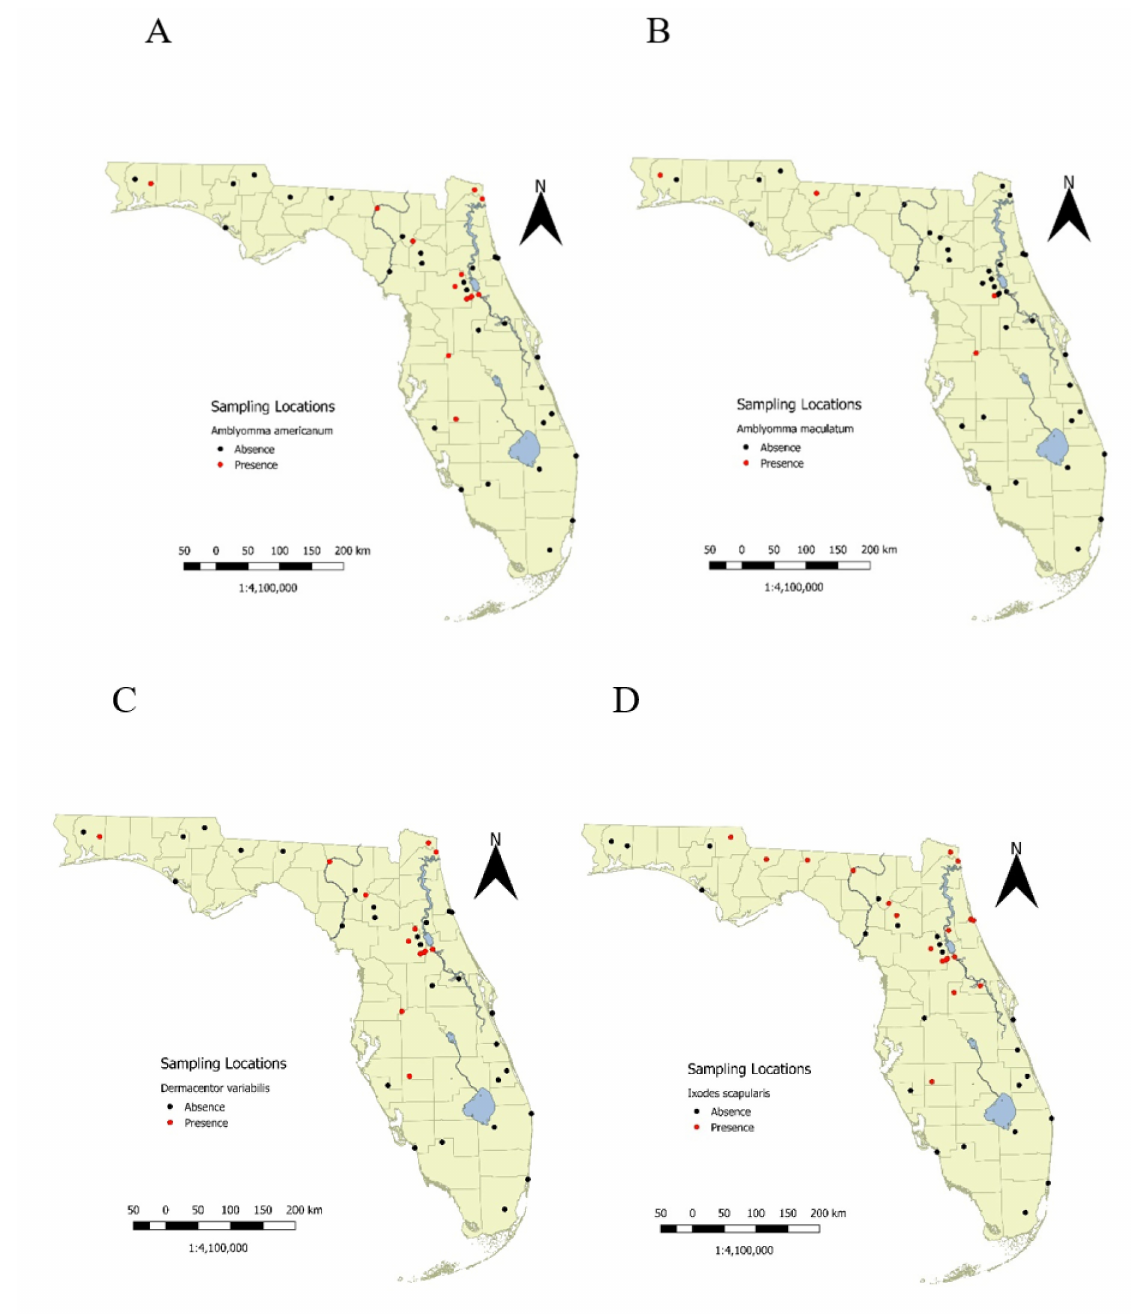
Figure 2. A–D. Sites with ticks present (red) or absent (black) during surveys between 2015–2018. ( A ) A. americanum . ( B ) A. maculatum . ( C ) D. variabilis . ( D ) I. scapularis